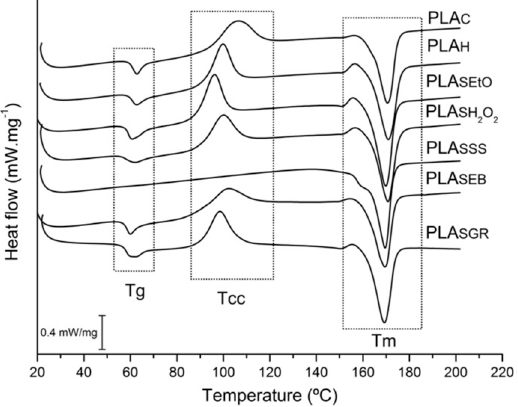
Figure 1. PLA DSC thermogram before and after the hygienization process and the five sterilization processes. (PLAC) control, (PLAH) hygienized, (PLASEtO) sterilized with ethylene oxide, (PLASH2O2) sterilized with hydrogen peroxide plasma, (PLASSS) sterilized with saturated steam, (PLASEB) sterilized with electron bean radiation, (PLASGR) sterilized with gamma radiation. Reprinted from M. Savaris, V. dos Santos, R.N. Brandalise, Mater. Sci. Eng. C 2016, 69, 661–667 [26]. Copyright 2019, with permission from Elsevier.